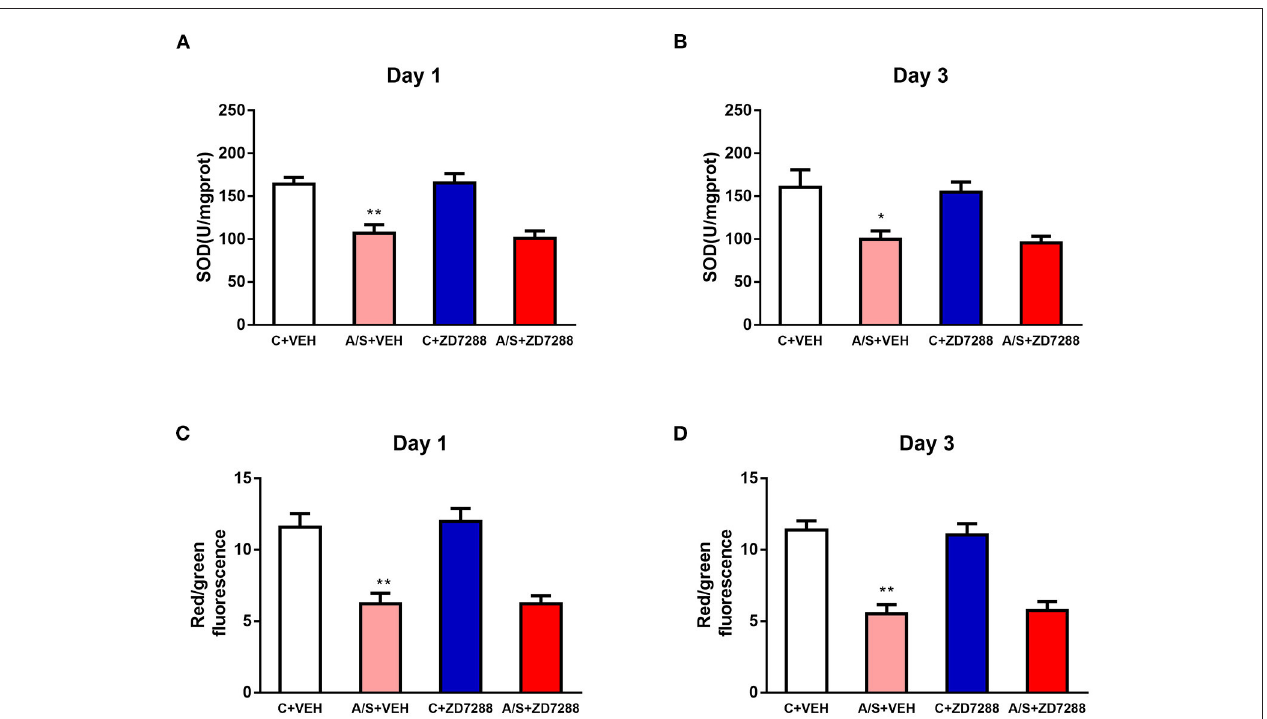
FIGURE 7 | Effect of HCN1 inhibitor on mitochondrial oxidative levels. (A–D) Analysis of SOD2 and MMP in the mPFC region among the four groups ( n = 6 per group, * p < 0.05; ** p < 0.01). Data are presented as the means ±